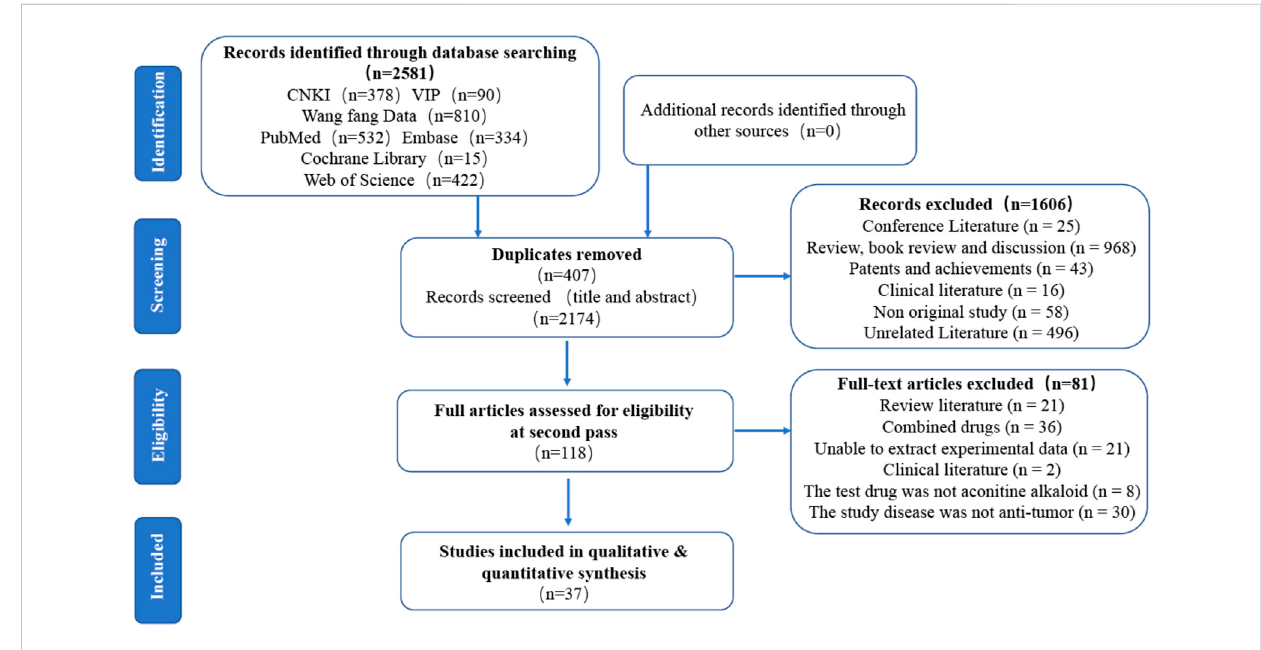
FIGURE 3 Flow chart of the database search and study identi fi